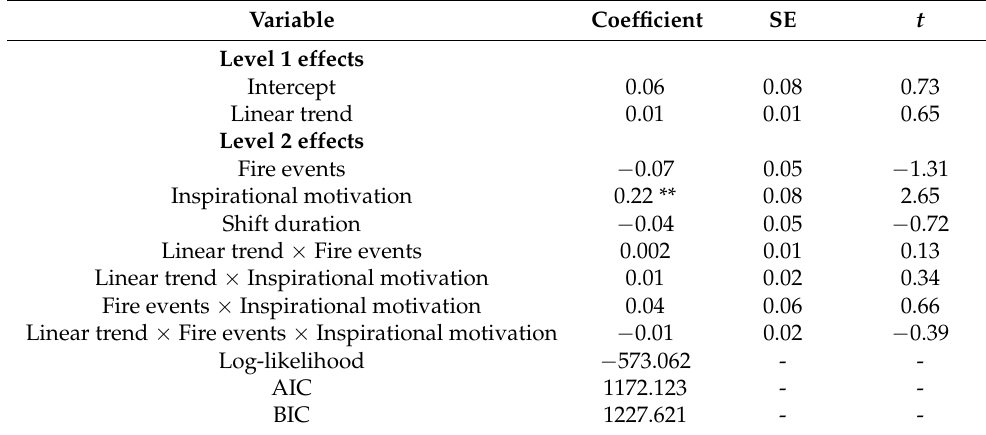
Table A3. Fire Events and Inspirational Motivation Predicting Change in Work Engagement.